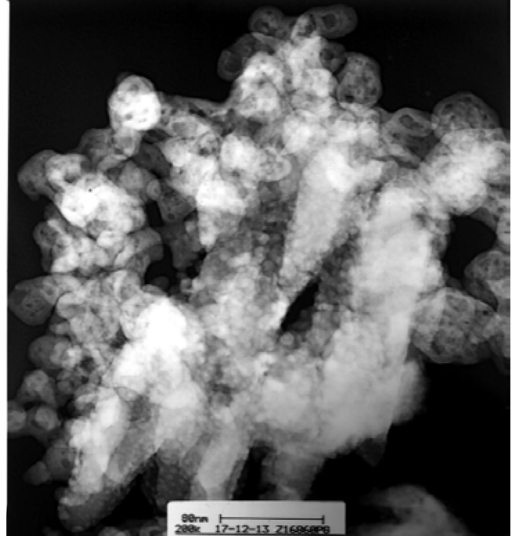
NPs Fig. 6: TEM image of Ir-doped TiO 2